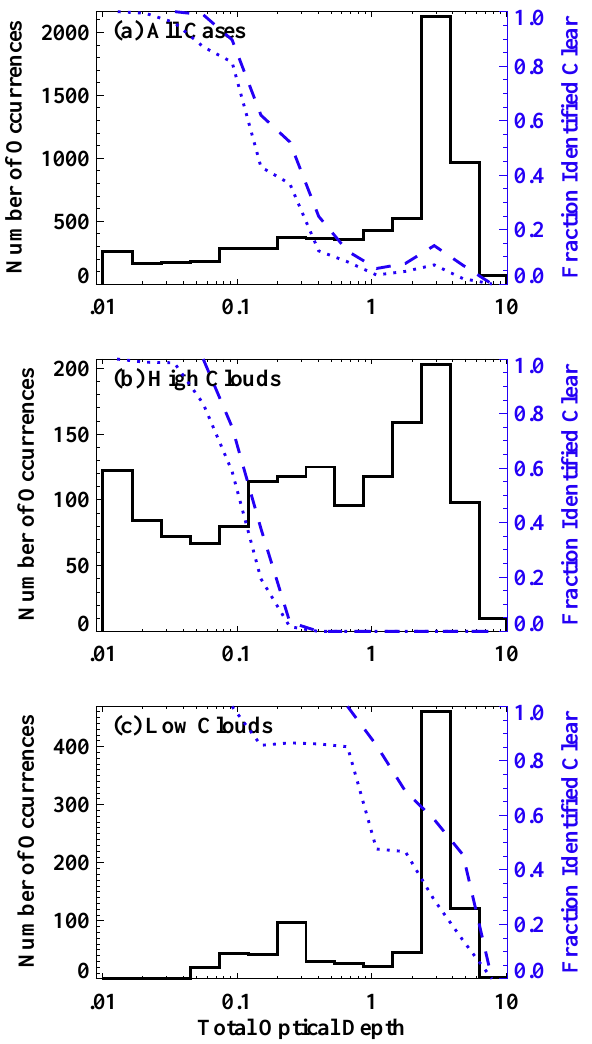
Fig. 6. (a) Distribution of cloud plus aerosol optical depth (AOD) for the synthetic orbits (solid line) and fraction of scenes identified as clear by the cloud screening algorithm (dashed and dotted lines). The dashed line shows the result for the operational thresholds, while the dotted line shows the result when the | 1P s , cld | thresh- old is tightened to 10hPa. (b) Same as panel (a) , but only shows those cases where 95% of the AOD resides in the upper 40% of the atmosphere (high clouds). (c) Same as panel (a) , but only shows those cases where 95% of the AOD resides in the lowest 30% of the atmosphere (low clouds).